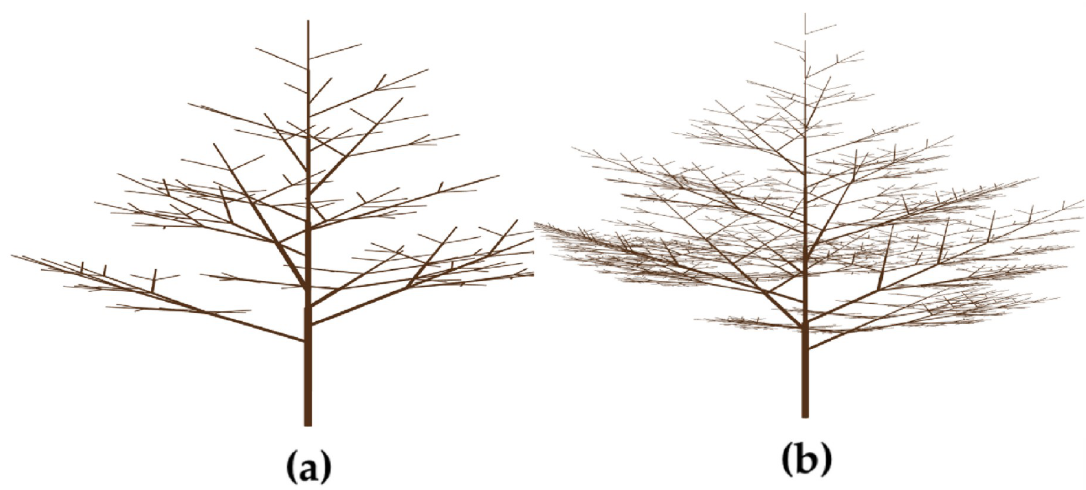
Fig 1. The branching structures of trees generated by a L-system. (a) The structure with four iterations. (b) The structure with six iterations.